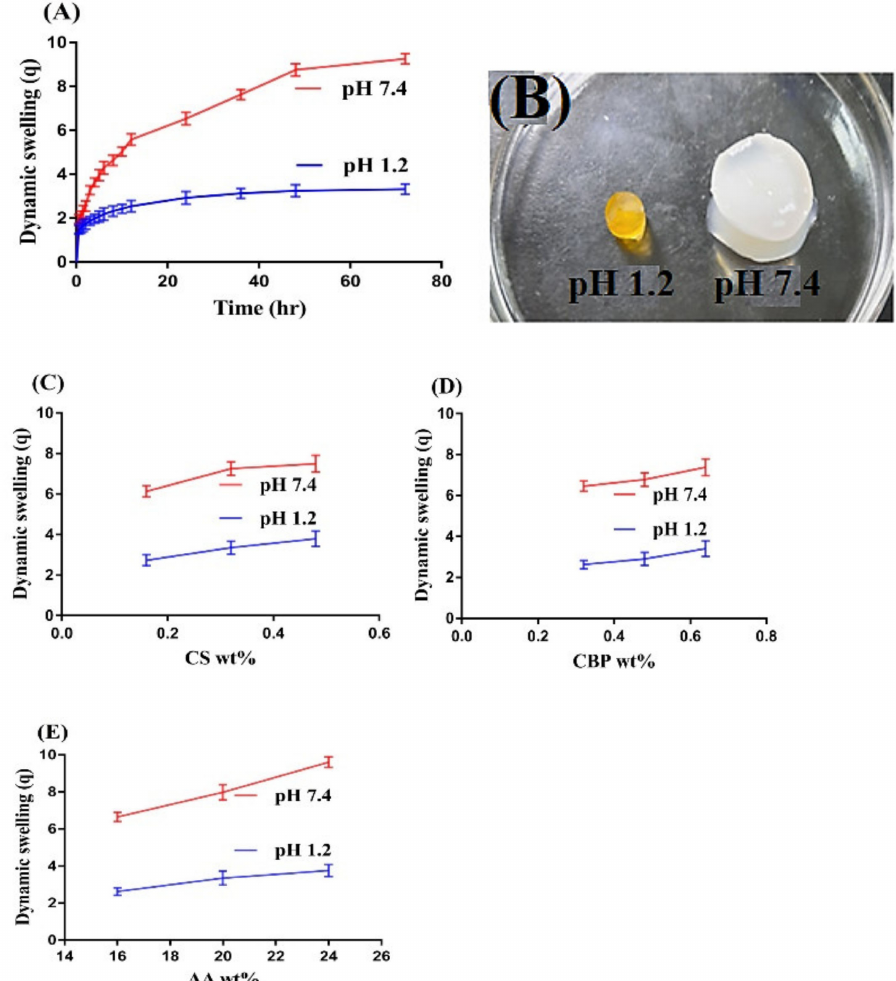
Figure 6. ( A ) Effect of pH on swelling dynamics; ( B ) swelled hydrogel at pH 1.2 and 7.4; effect of ( C ) CS (Chondroitin sulfate), ( D ) CBP (Carbopol), and ( E ) AA (Acrylic acid) on dynamic swelling of CS/CBP-co-PAA